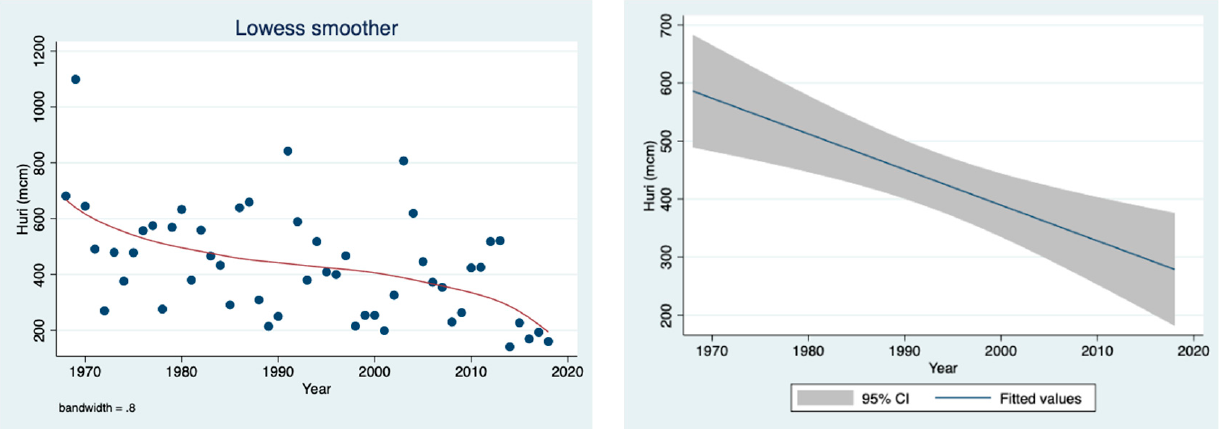
Figure 3. Linear prediction (95% CI) ( left ) and LOWESS smoother (0.8 bandwidth) trend of changes ( right ) between annual discharge (mcm;10 6 m 3 per year) of River Jordan (Huri Station) during 1968–2018.